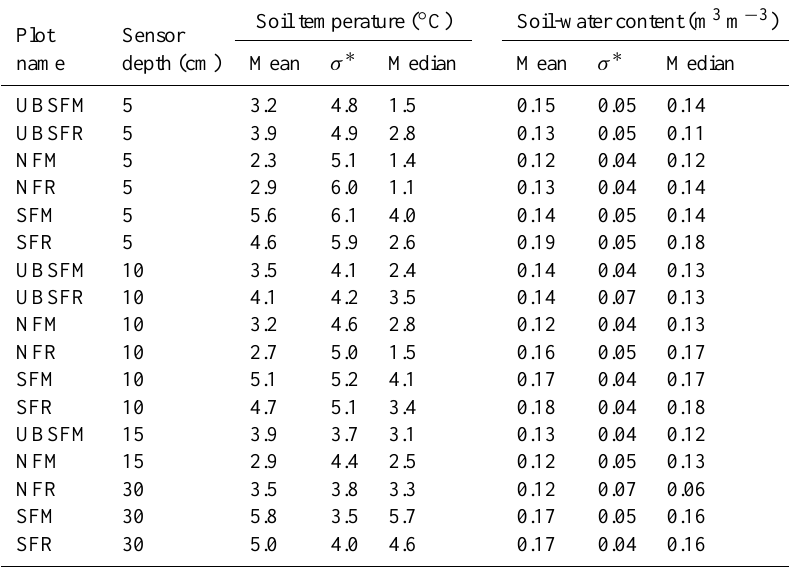
Table 3. Statistics of soil temperature and volumetric soil-water content from the automated sensors (Decagon 5TE). Soil temperature ( ◦ Plot Sensor